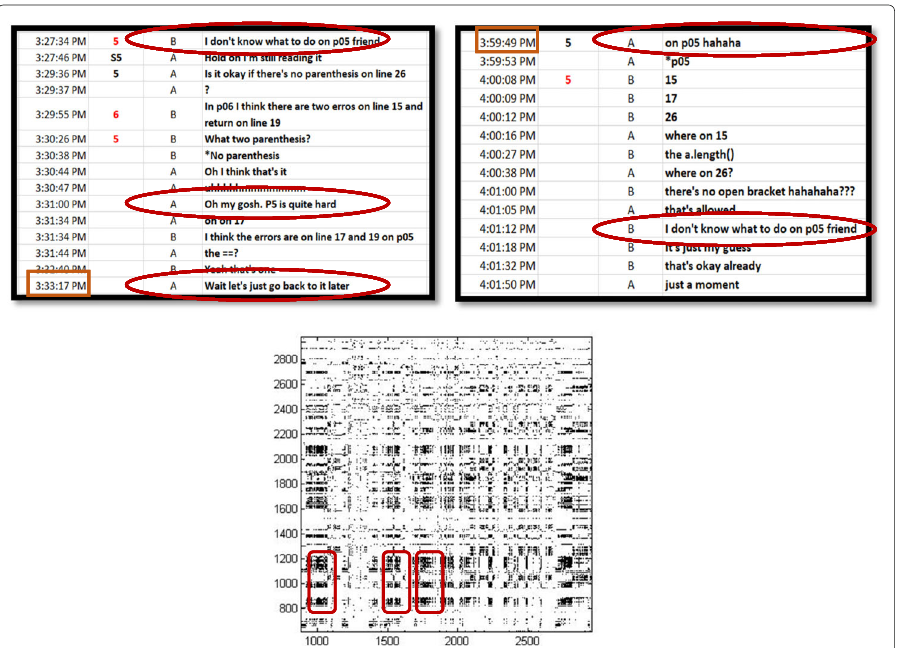
Fig. 9 Sample chat transcript showing the pair skipping a problem and returning to it (top) and the CRP with the visually recurring patterns